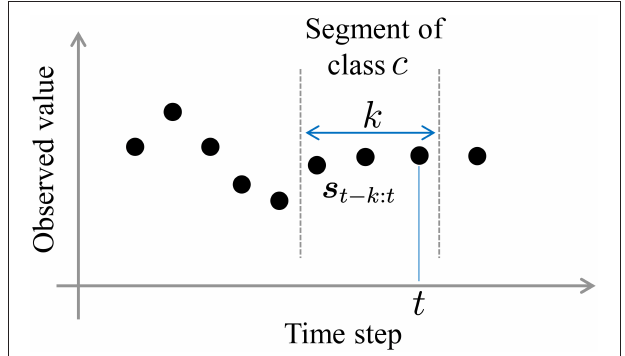
FIGURE 5 | A segment whose probability is computed during forward filtering.